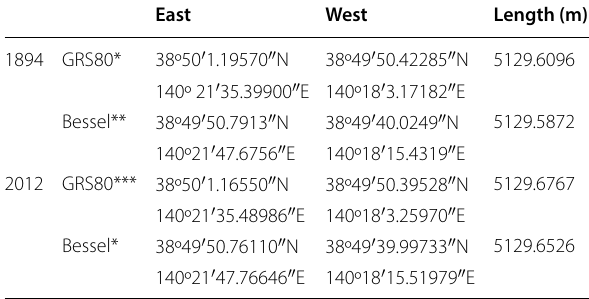
Table 4 and Additional file 2: Figure S2 summarizes